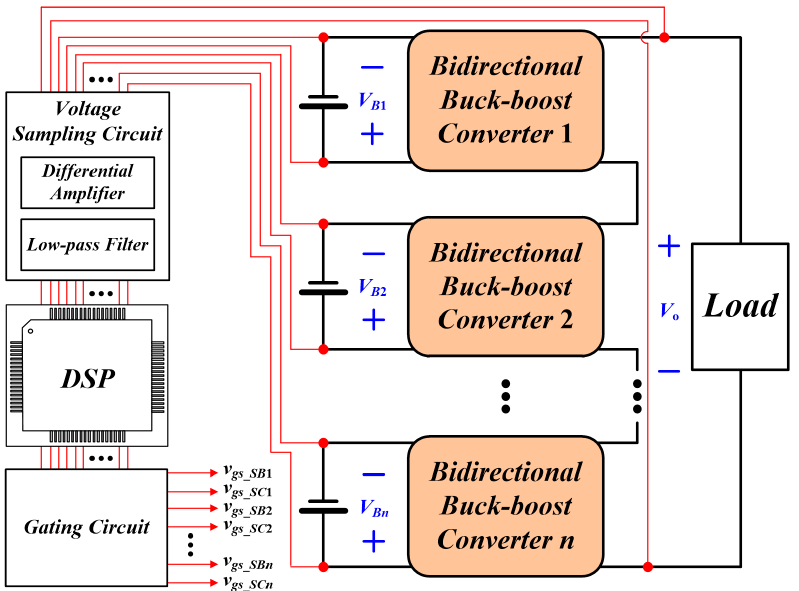
Figure 5. Series buck–boost BPMs with peripheral control units.